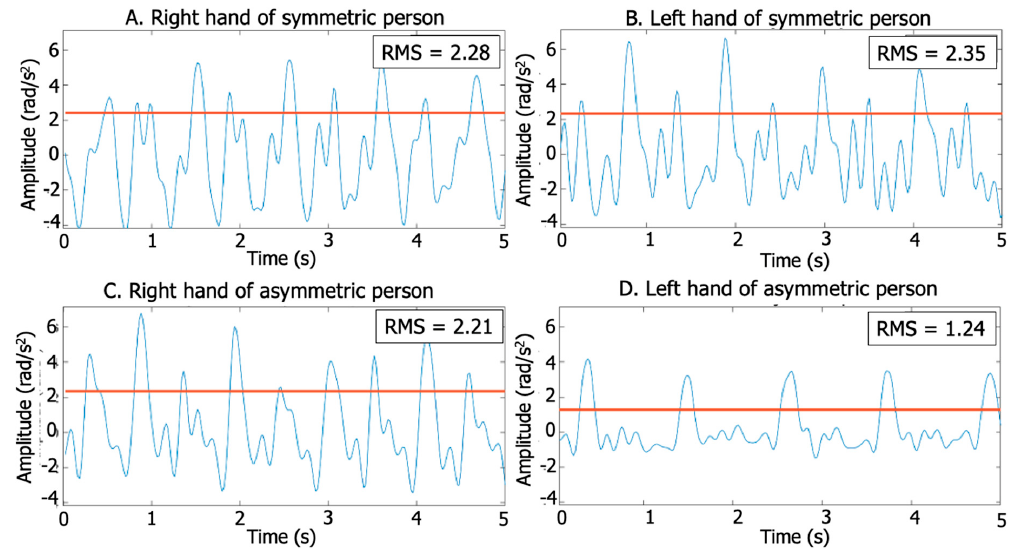
Figure 2. Acceleration signal and RMS for an PD patient and a control. ( A ) Control right arm swing. ( B ) Control left arm swing. ( C ) PD patient right arms swing. ( D ) PD patient left arm swing. Note that the patient exhibits very different RMS, due to waveform and amplitude between limbs.